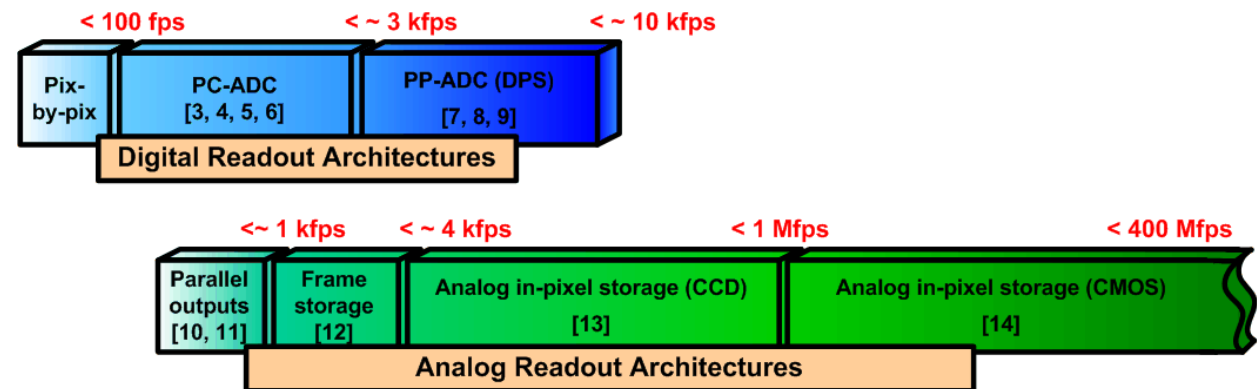
Figure 2. A block-diagram categorizing some of the most relevant published high-speed imagers [3-14], showing the frame rates that can be achieved by different readout